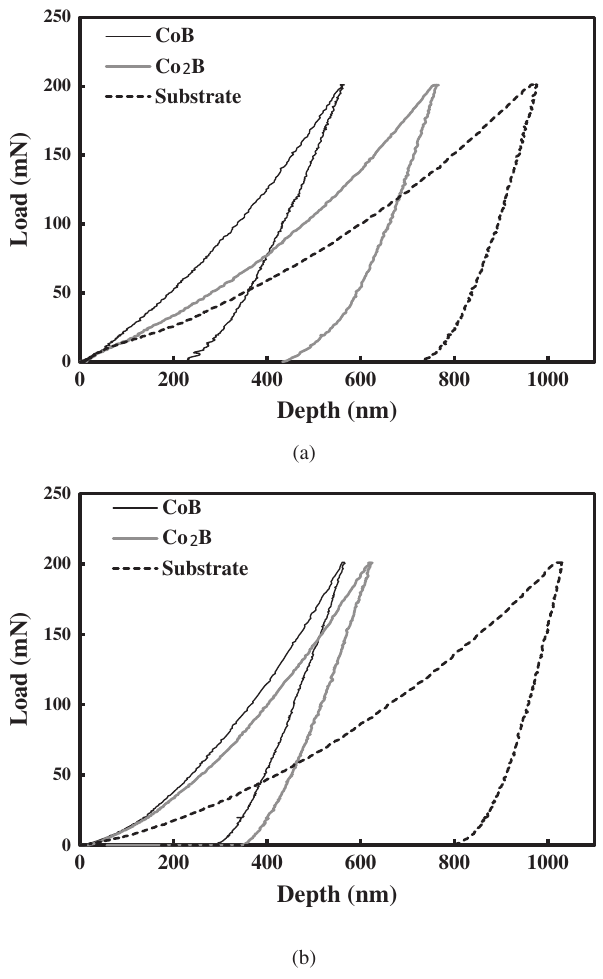
Figure 2: The depth-sensing Vickers microindentation: (a) load – displacement plots obtained on the cobalt boride layers developed at the surface exposed to the anode, and (b) load – displacement plots obtained on the cobalt boride layers developed at the surface exposed to the cathode. The CoB – Co 2 B layers were developed at 1148 K with 2 h of